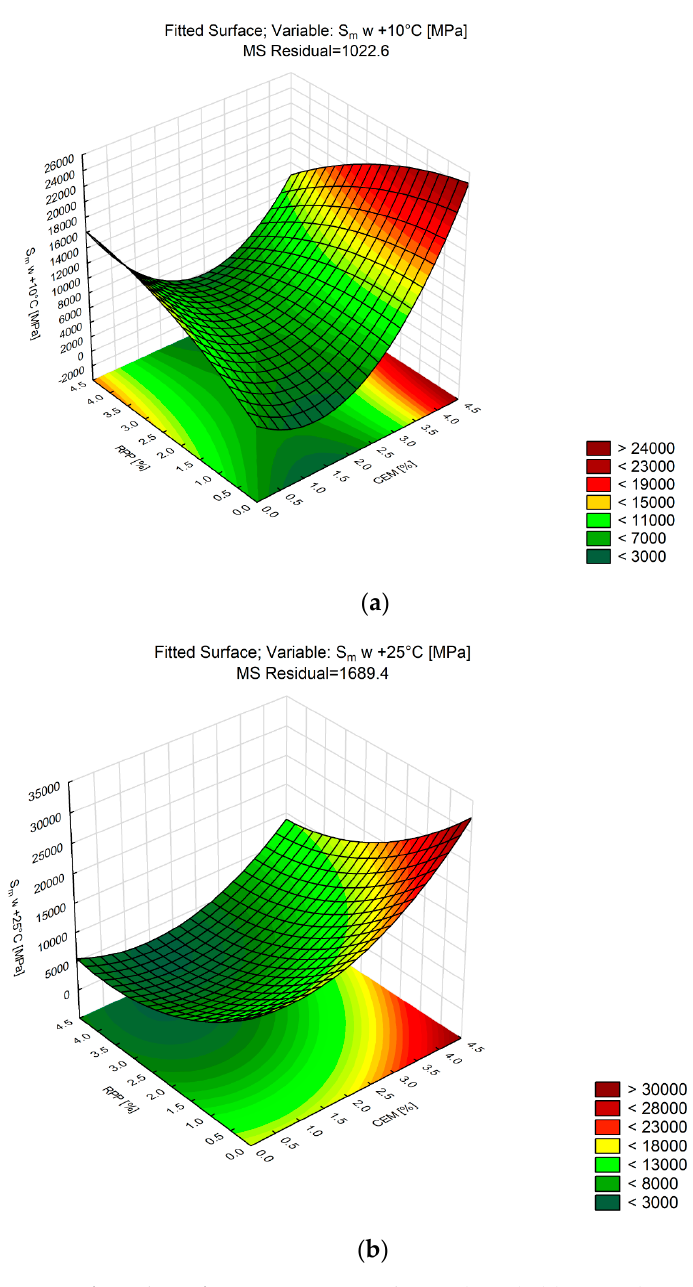
Figure 11. Response surface plots of S m versus RPP and CEM (CBM): ( a ) at +10 °C; and ( b ) at +25 °C.